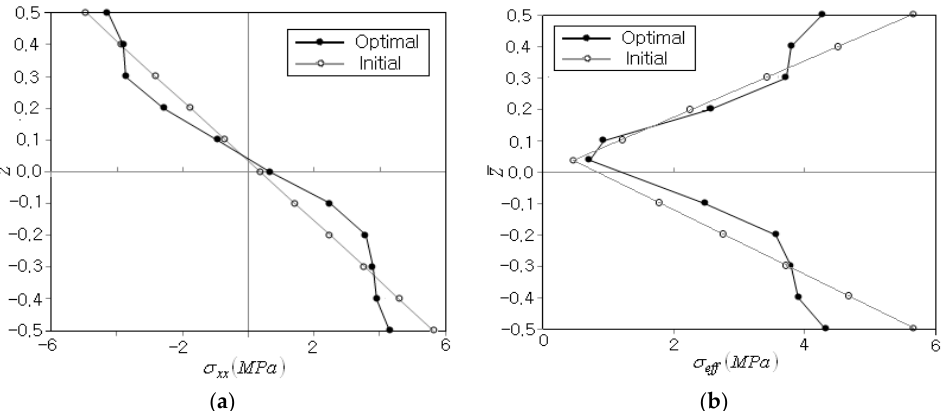
Figure 9. Comparison of thickness-wise stress distributions ( α = 45 ◦ ): ( a ) the axial stress, ( b ) the